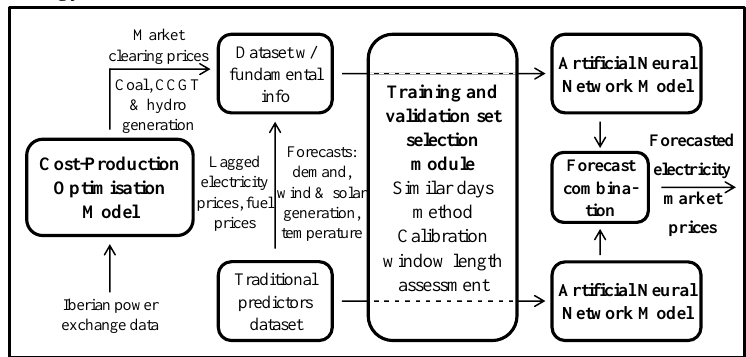
Figure 1. Overview of the proposed fundamental-econometric model.